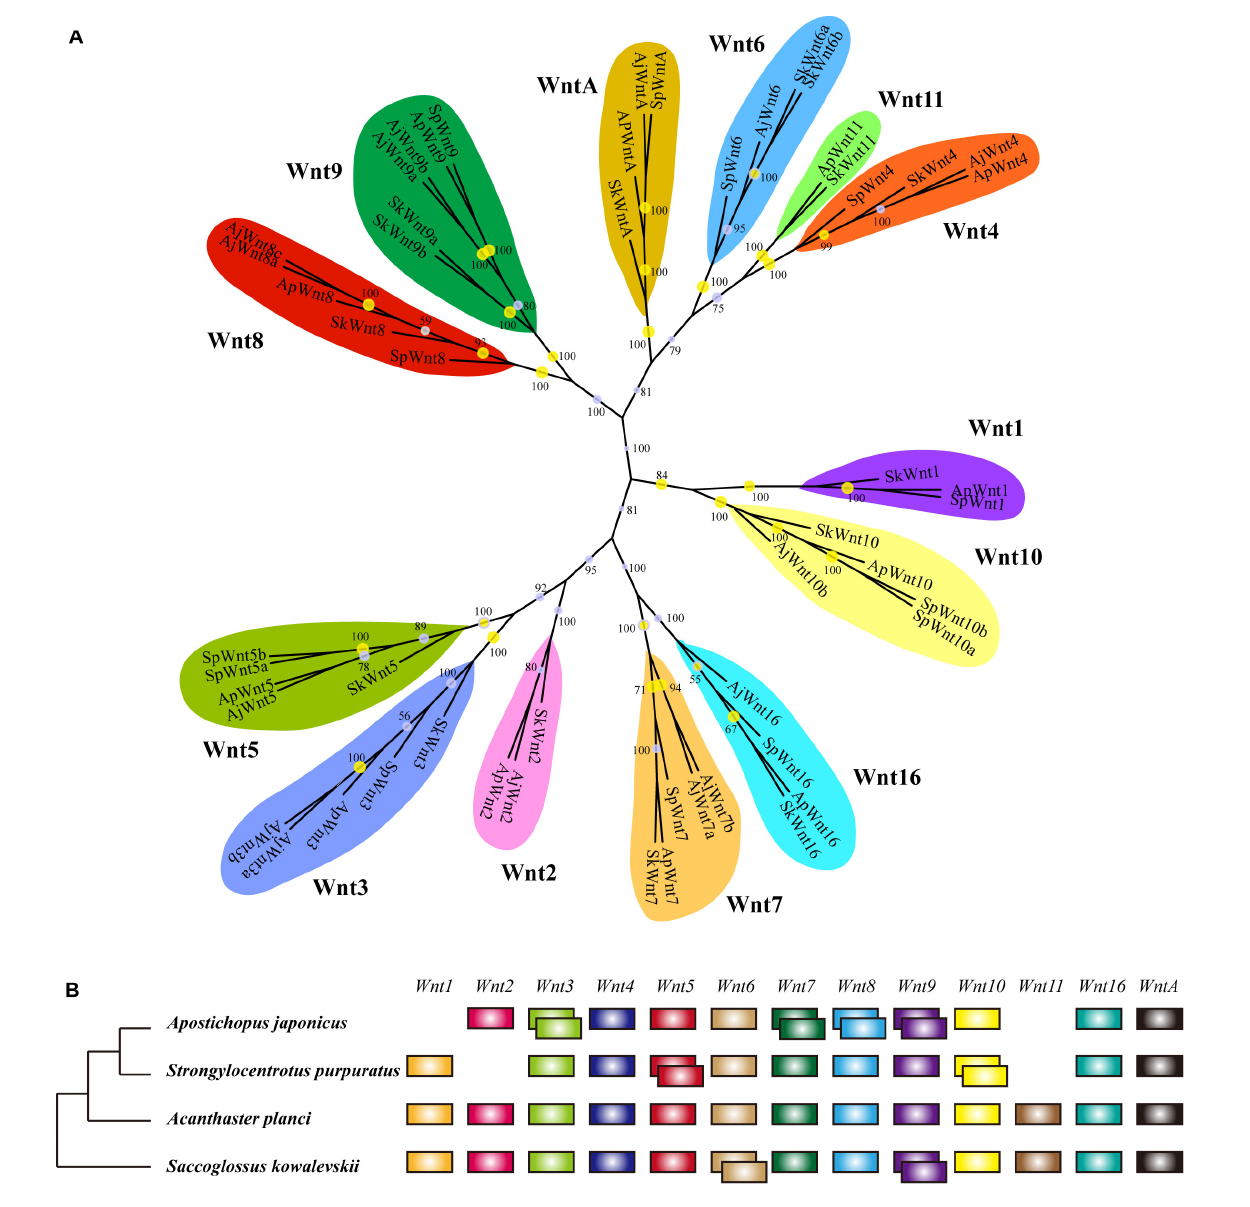
FIGURE 3 | Wnt gene family in echinoderms. (A) Phylogenetic tree of the Wnt gene family of three echinoderms and Saccoglossus kowalevskii . The phylogenetic tree is constructed using the maximum likelihood (ML) method with 1000 bootstraps and Bayesian inference (BI). Yellow circles indicate the support values of ML analysis larger than 80%. The support values of BI analysis are displayed beside each node. (B) Comparison of Wnt gene family members across echinoderms and S. kowalevskii . Empty indicate the loss of particular Wnt genes, and overlapping boxes represent duplicated Wnt genes.